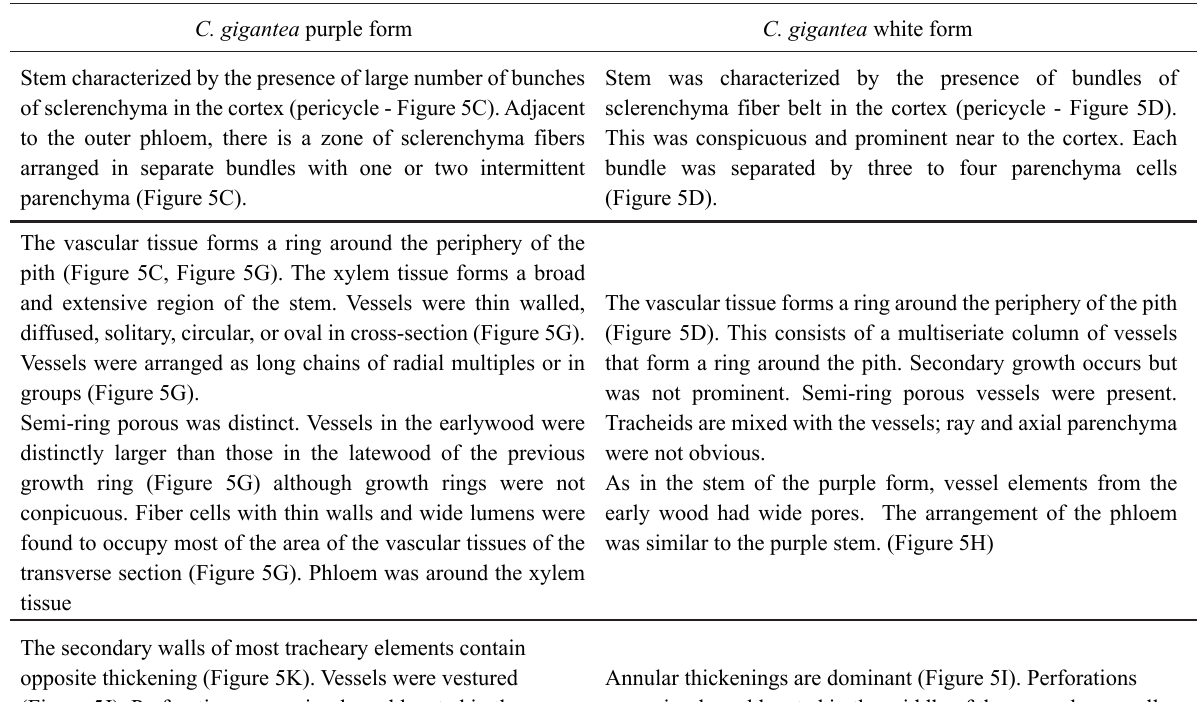
Table 1: Comparison of stem anatomy of the purple and white forms of Calotropis gigantea